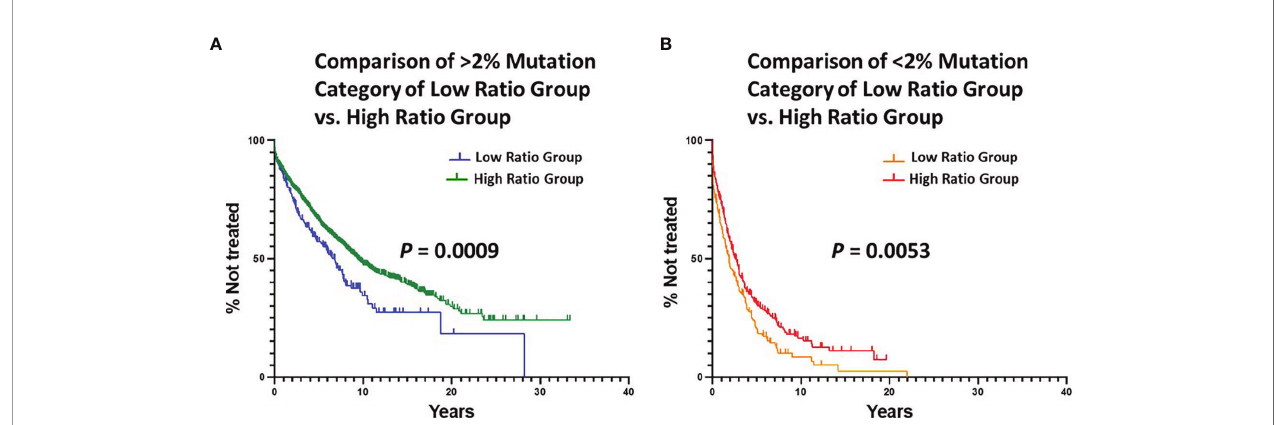
FIGURE 3 | Comparison of estimated TTFT in the < 2% and ≥ 2% mutation categories of the Low Ratio Group and the High Ratio Group. (A) Comparison of TTFT in ≥ 2% mutation category of Low vs. High Ratio Groups ( P = 0.0009). Number of cases from Low Ratio group: 222, 119 treated (median TTFT = 6.78 years). Number of cases from High Ratio group: 1663, 737 treated (median TTFT = 9.38 years). (B) Comparison of TTFT in < 2% mutation category of Low vs. High Ratio Groups ( P = 0.0053). Number of cases from Low Ratio group: 183, 152 treated (median TTFT = 1.91 years). Number of cases from High Ratio group: 271, 199 treated (median TTFT = 2.59 years).